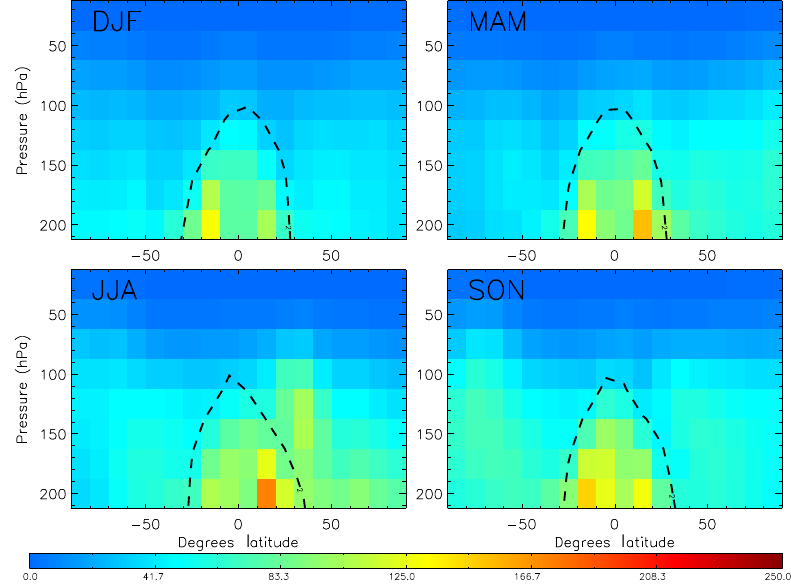
Figure 6. As Fig. 5 but for the UoL MIPAS retrieval.